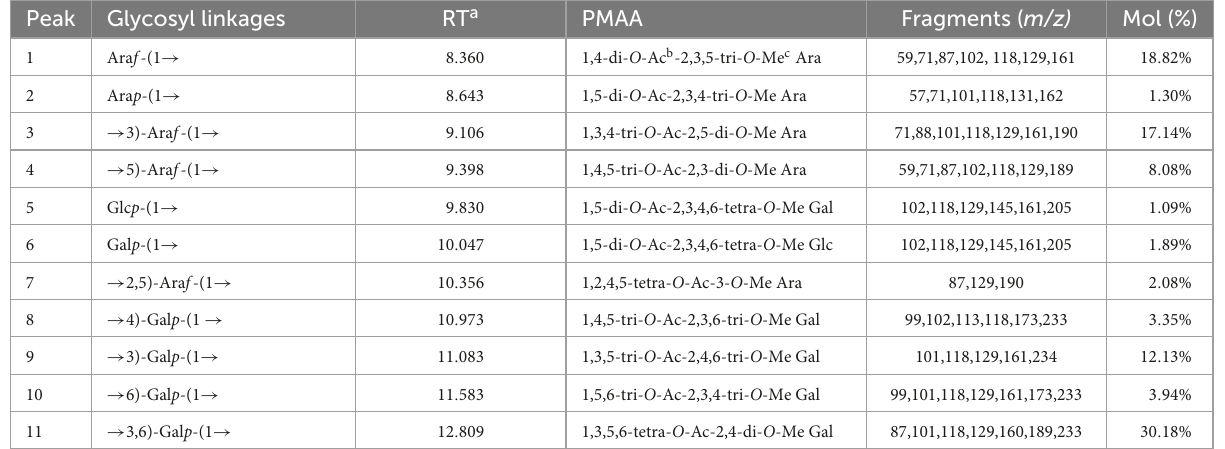
TABLE 1 Glycosidic linkage composition of